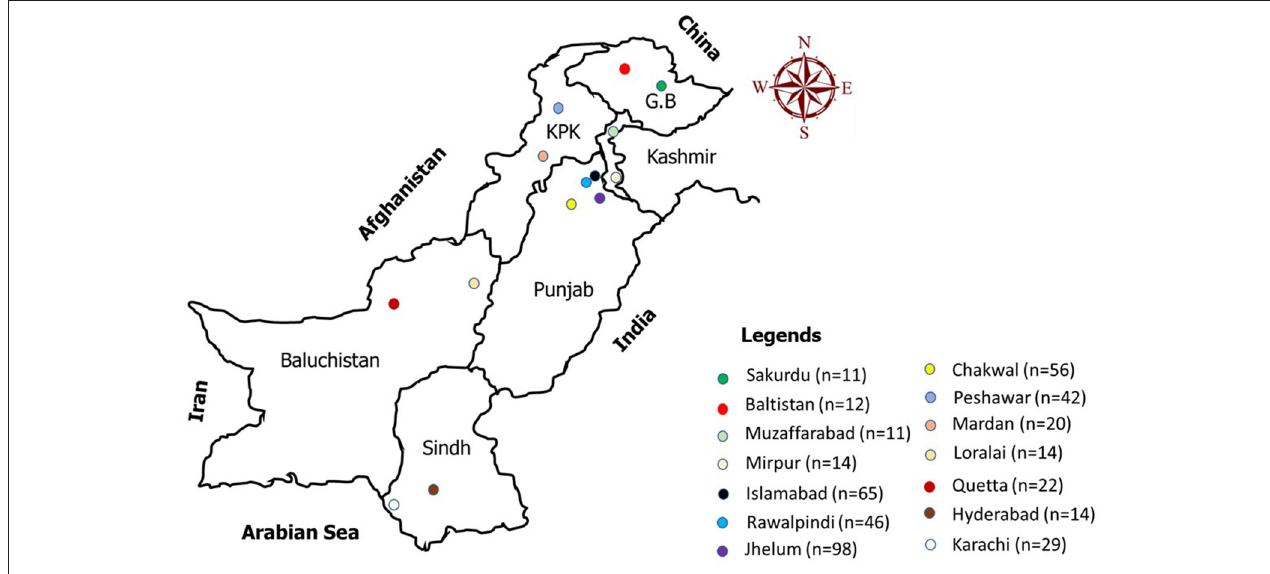
FIGURE 1 | Map of Pakistan with multiple dots depicting the sampling sites where the data were